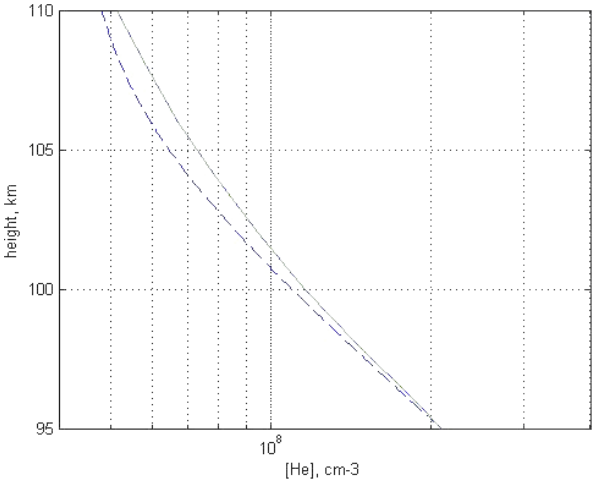
Fig. 5a. [He] height profiles in winter solstice given by the MSIS- E-90 model (solid curve) and calculated (dashed curve) with the eddy diffusion coefficient shown in Fig. 4 ( K m z m = 95km, s = 0 . 01km − 2 ) .